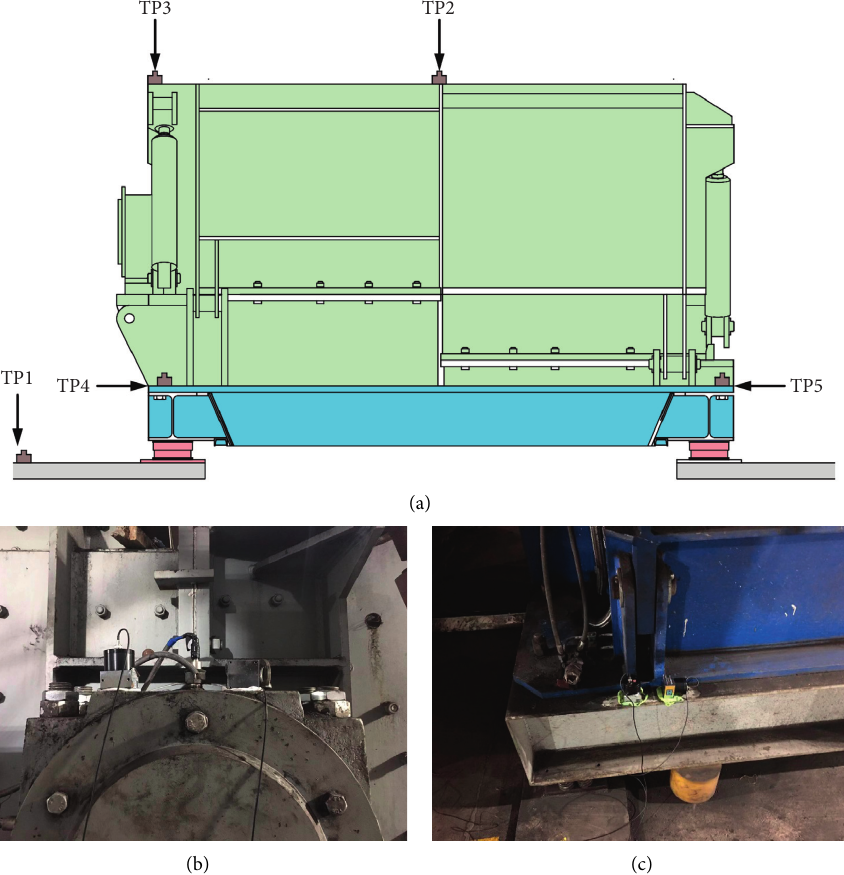
Figure 4: Vibration test. (a) Arrangement of measurement points. (b) Vibration sensor on the machine. (c) Vibration sensor on the